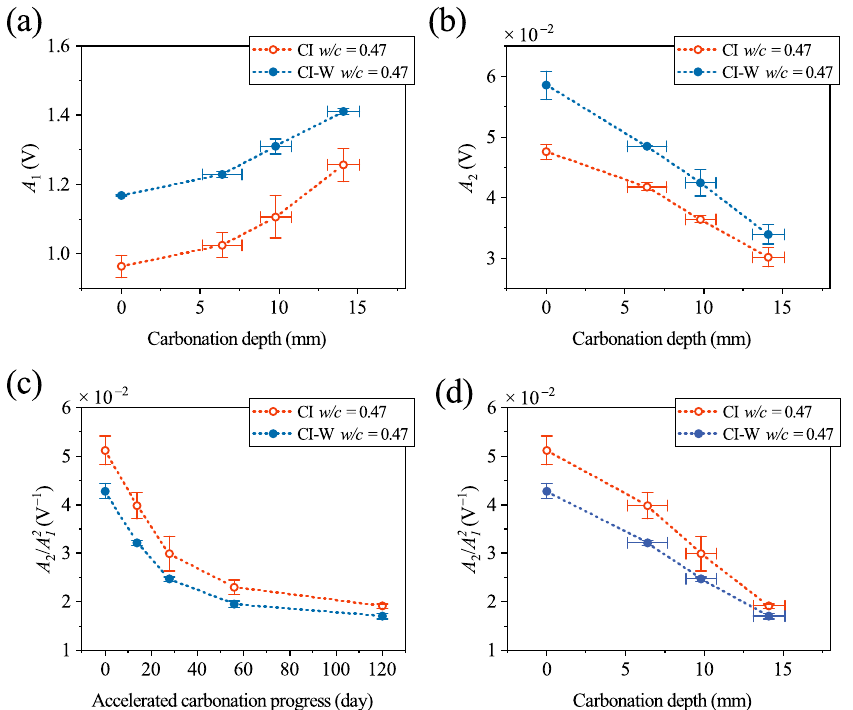
Figure 10. Fundamental amplitudes, harmonic amplitudes and non-linear parameters of CI (dry) and CI-W (water saturation